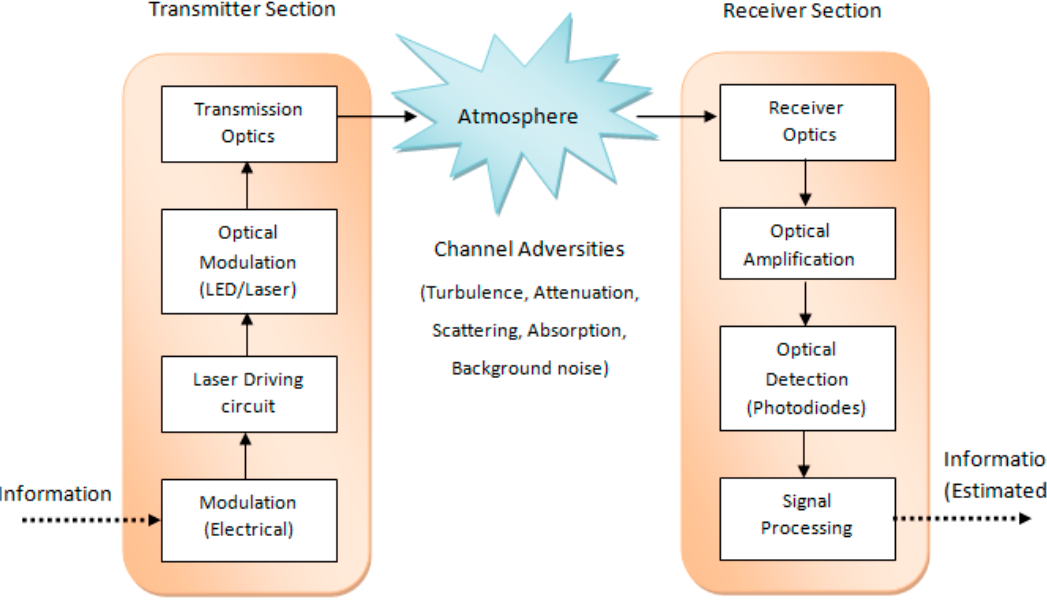
Figure 1. Block diagram of signal modulation, propagation and detection in free-space optics (FSO) link.